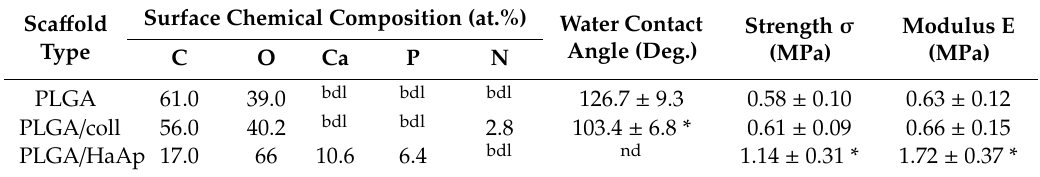
Table 1. Properties of the sca ff olds: surface chemical composition (excluding hydrogen), water contact angle, strength, and modulus E in compression